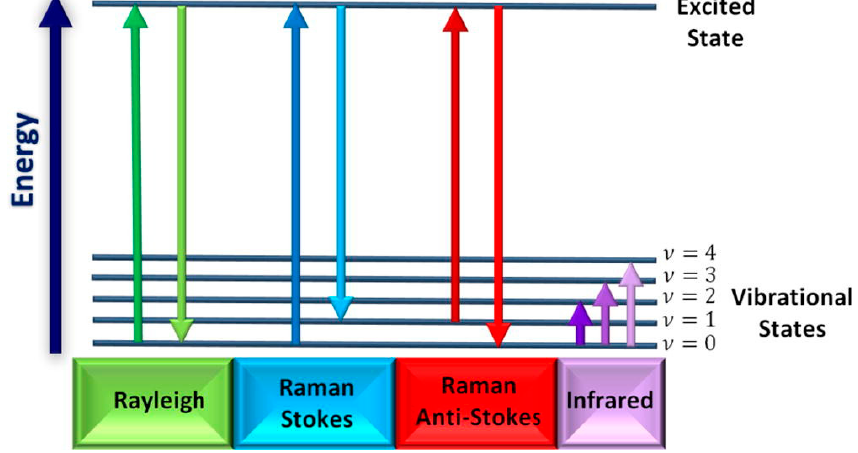
Figure 9. Modified energy diagram for Rayleigh and Raman scattering. Adapted from [109], with permission from © 2018 Elsevier.